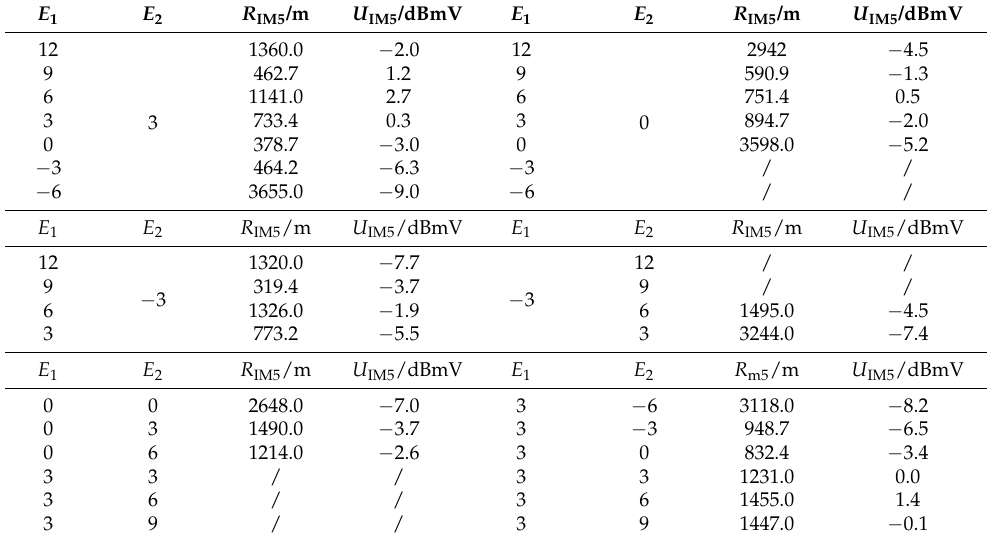
Table 3. Test data of the IMFA − 5 signal with the interference field